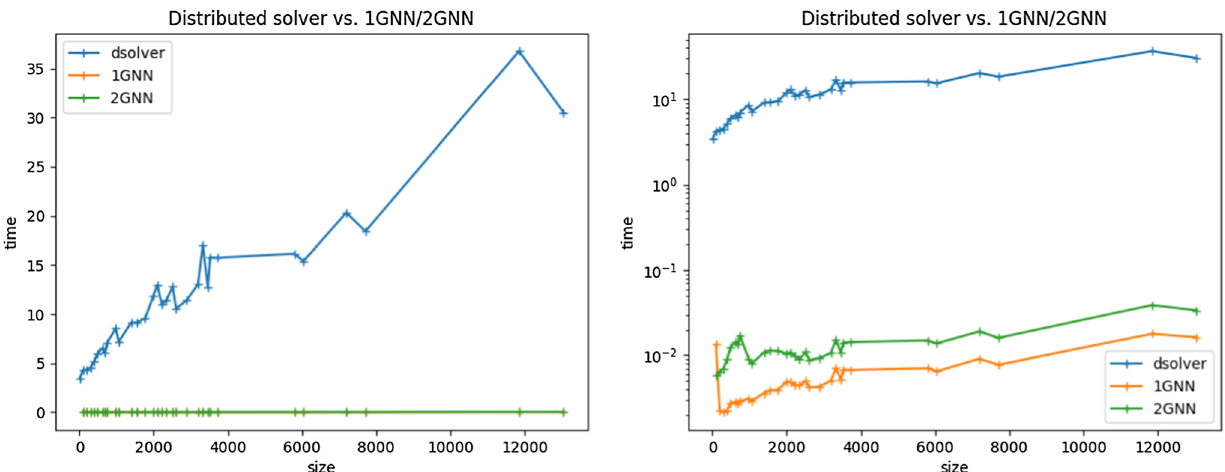
Fig. 5 Execution time of the distributed solver versus the execution time of the 1GNN and 2GNN models. Plot on the left side in linear scale on the y -axis, and plot on the right side in log scale